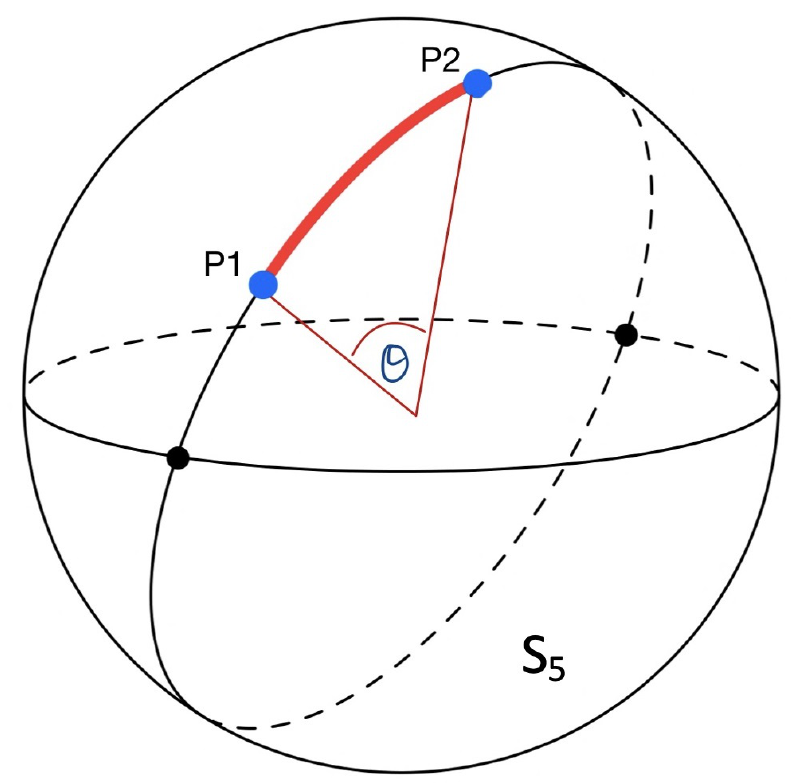
Figure 2. The Riemann distance between two participants, P 1 and P 2, on S 5